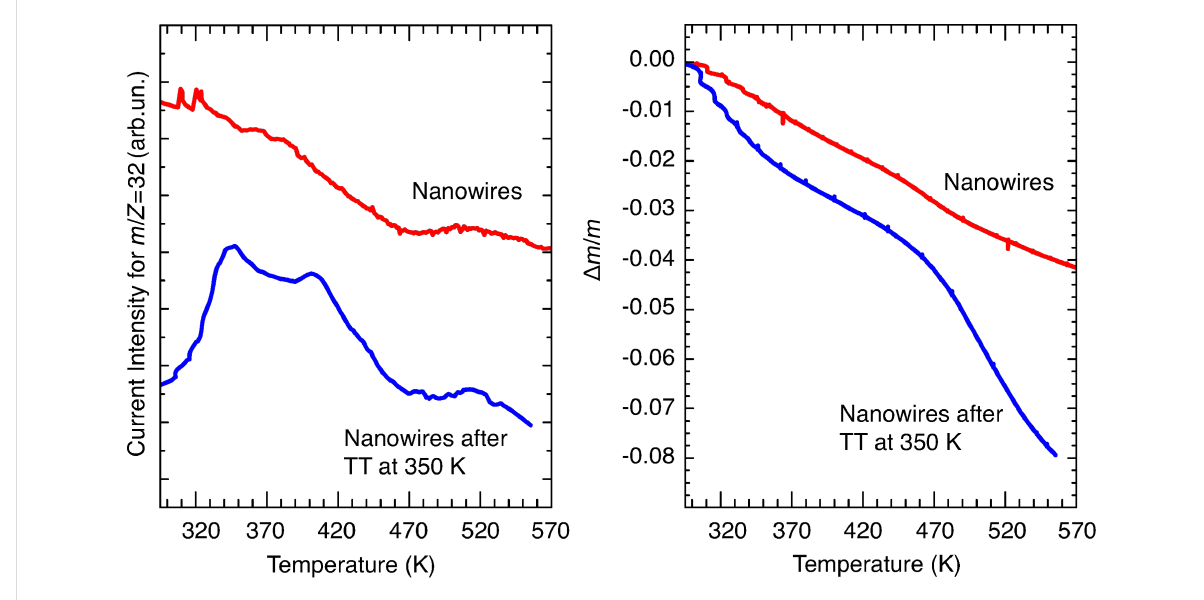
Figure 1: Temperature dependence of the signal of the mass spectrometer for m / z = 32 (left) and of the total mass variation Δ m / m (right), of the as-produced nanowire sample (red lines, sample 1) and of the nanowire specimen after a thermal treatment (TT) at 350 K for 24 h in vacuum (blue lines, sample 2).